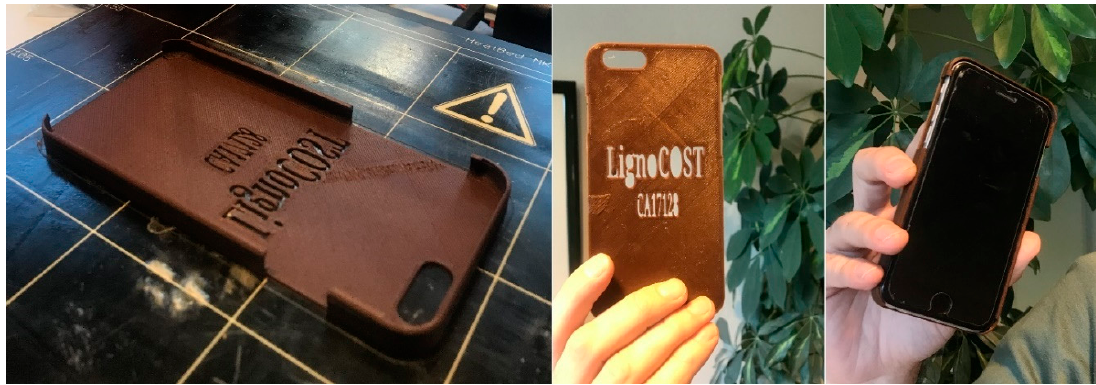
/ lignin biocomposite